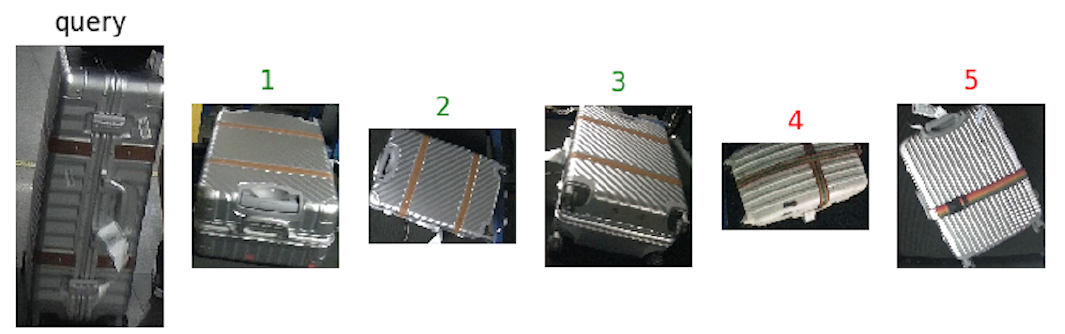
Figure 10. Results with with Squeeze-and-Excitation Networks (SENet) as backbone. Green labels are correct query answers, while the red ones indicate different